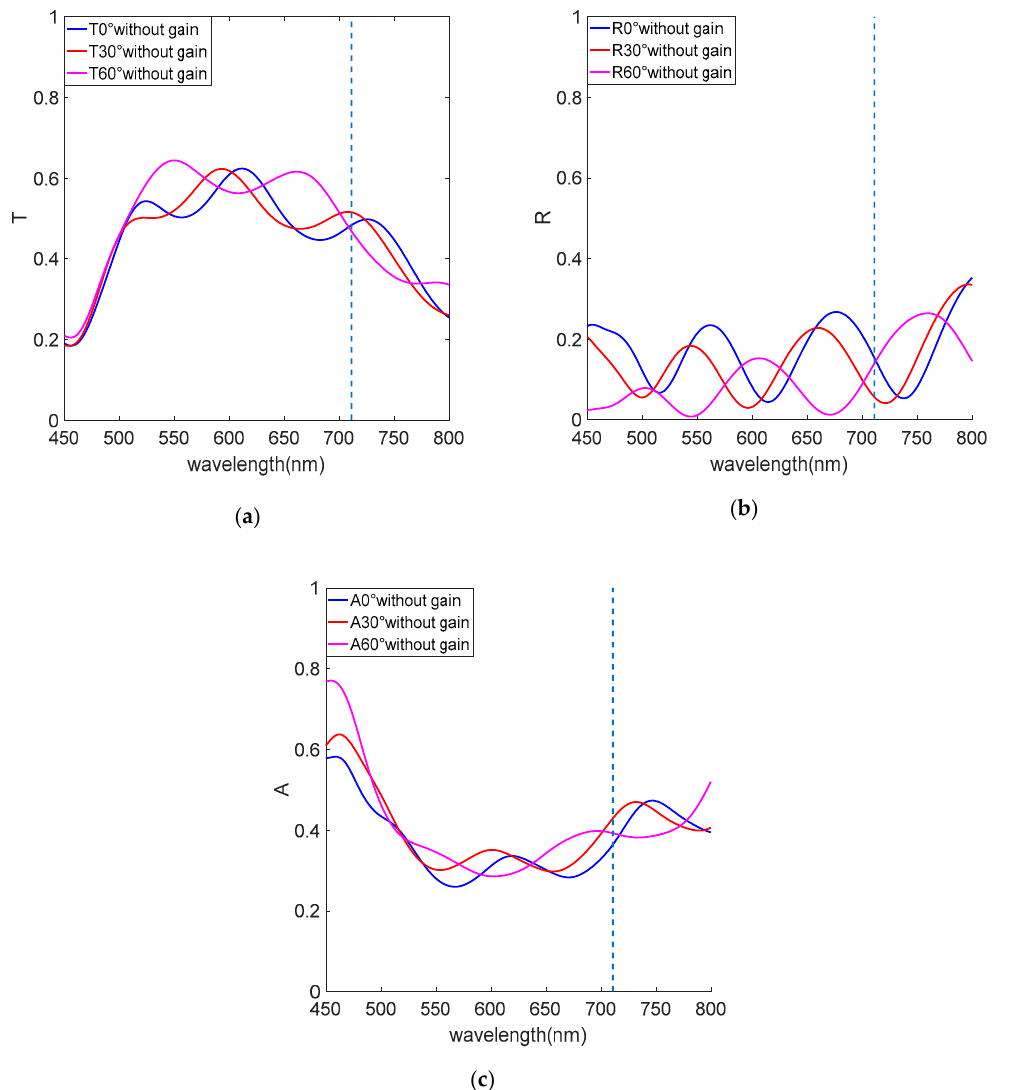
Figure 5. Optical properties without gain medium. ( a ) Transmittance. ( b ) Reflectance. ( c ) Absorp- tion.